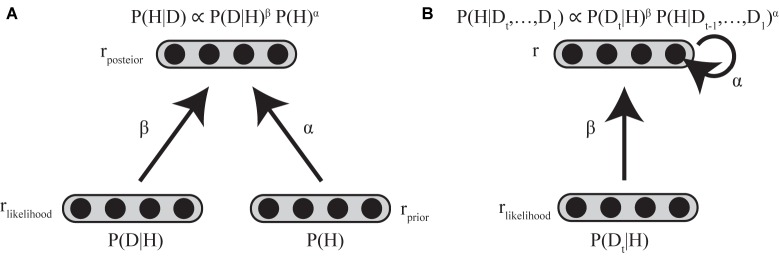
Neural implementation of biased Bayesian inference (A) Feed-forward implementation. The first layer consists of two neural populations encoding prior and likelihood, and the second layer consists of neural populations encoding posterior distribution. rprior, rlikelihood, and rposterior indicate the firing rates of the corresponding populations. Standard Bayesian inference is achieved by summing firing rates of corresponding neurons between the neuronal population encoding prior and that encoding likelihood at the next layer of the neuronal population encoding the posterior distribution (rposterior = rprior + rlikelihood) in case that the firing rates are proportional to log probabilities (Ma et al., 2006; Yang and Shadlen, 2007). The biased Bayesian inference can be achieved just by changing the gain (α,β) of the inputs for the next (posterior) layer (rposterior = αrprior + βrlikelihood). (B) Recurrent implementation. The first layer consists of neural population encoding likelihood, and the second layer consists of neural population encoding of prior/posterior distributions. rlikelihood and r indicate the firing rates of the corresponding populations. Input to the second layer that encodes prior/posterior distribution is αr + βrlikelihood (t). α is strength of recurrent connection, β is the strength of feed-forward connection.